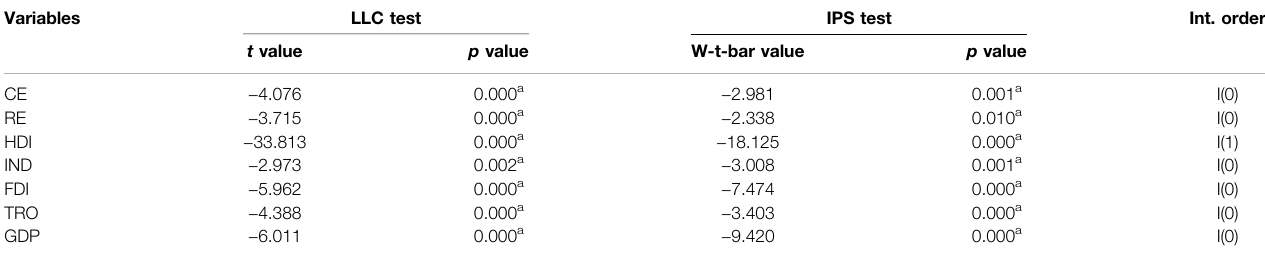
TABLE 4 | Test result of panel unit root-Upper middle-income